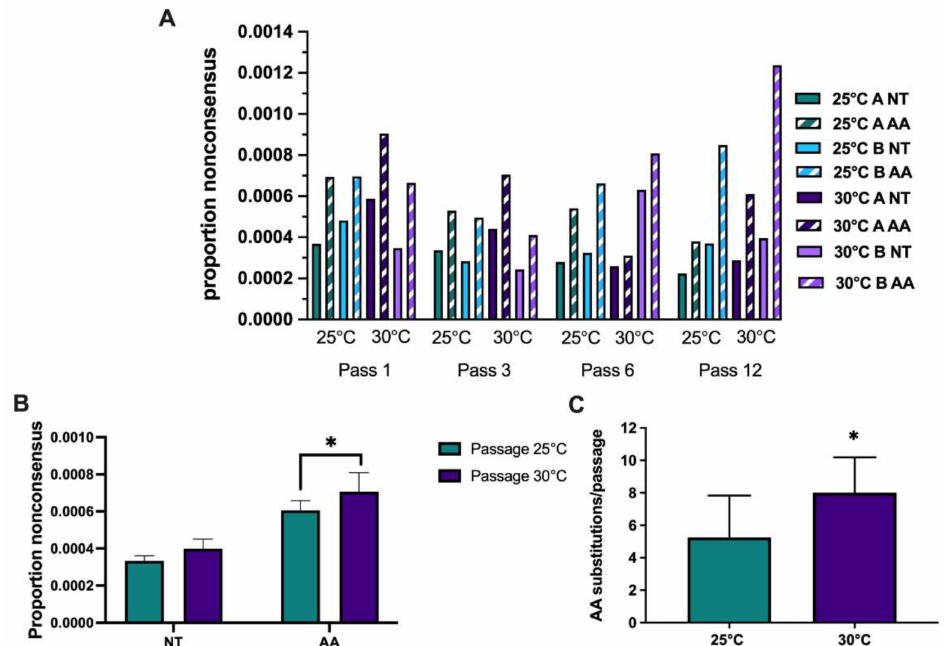
Figure 6. Increased nonsynonymous minority mutations identified in West Nile virus populations passaged at higher temperatures on mosquito cells. Deep sequencing was completed on the Illumina MiSeq platform and analyses were completed using Geneious R11 and MEGA X. ( A ) The proportions of nonconsensus nucleotide and amino acid variants >2% in each lineage during passage at either 25 ◦ C or 30 ◦ C are shown. Solid bars indicate nonconsensus nucleotide (NT) mutations and stripes indicate nonconsensus amino acid (AA) substitutions. ( B ) Mean proportions of nonconsensus nucleotide and amino acid variants identified at frequencies >2% during passage at 25 ◦ C or 30 ◦ C. A significantly higher proportion of nonconsensus amino acid substitutions was identified during WNV passage at 30 ◦ C (* p < 0.05, chi-square test). ( C ) A significantly higher proportion of unique amino acid substitutions at >5% per passage was identified in WNV populations passaged at 30 ◦ C (* p ≤ 0.05, t